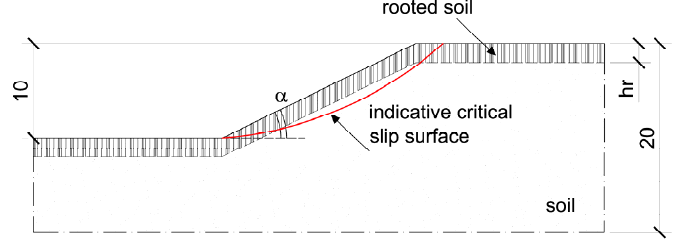
Figure 2. Schematic diagram of the slope geometry investigated in the research.